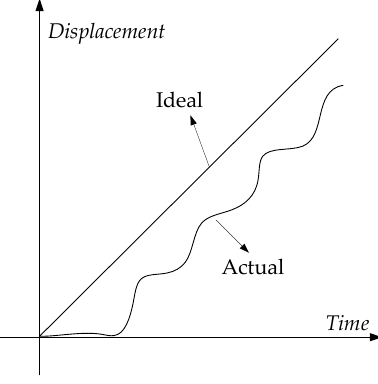
Figure 4. Crawling phenomenon. Figure 4. Crawling